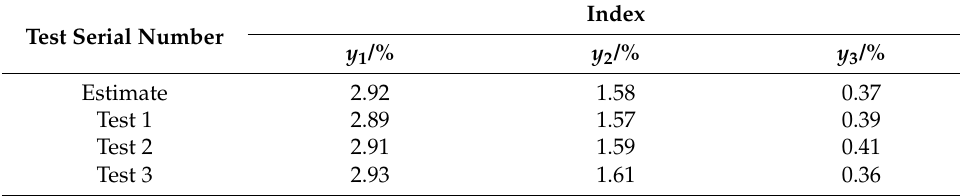
Table 5. Verification test